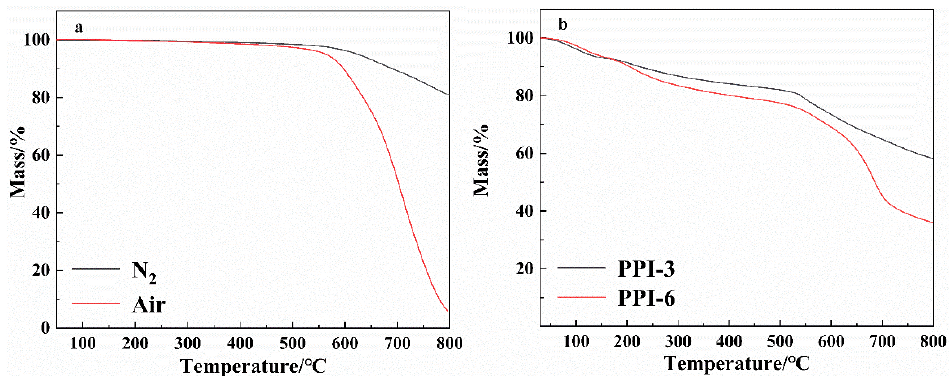
Figure 2. Thermal gravity analysis curves of pure PPI ( a ) and acid-doping PPI ( b ). Table 1. The inherent viscosity, TGA data, and T g of PPI.